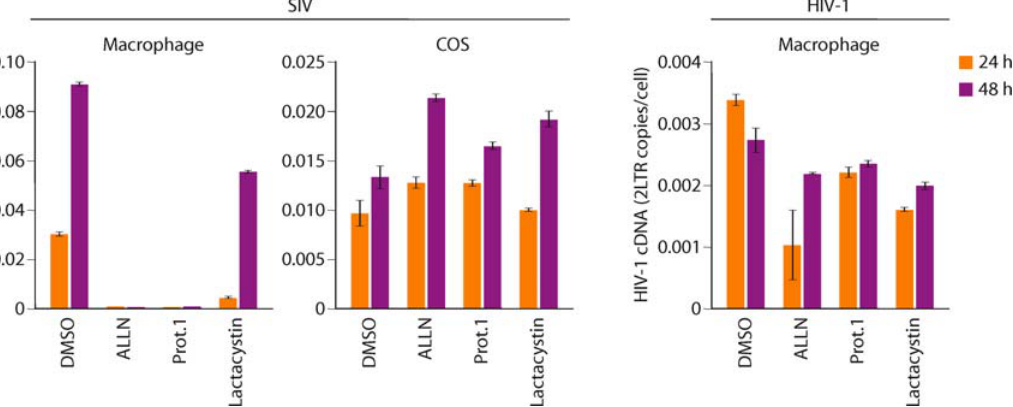
Figure 4. Differential impact of proteasome inhibition on SIV WT and HIV-1 infection of macrophages. Effects of 3 different proteasome inhibitors on SIV infection of macrophages and COS cells and HIV-1 infection of macrophages are indicated. Viral infection (2-LTR cDNA) was gauged at 24 and 48 h post infection (error bars and s.d. of 3 replicate measures of a single DNA sample).